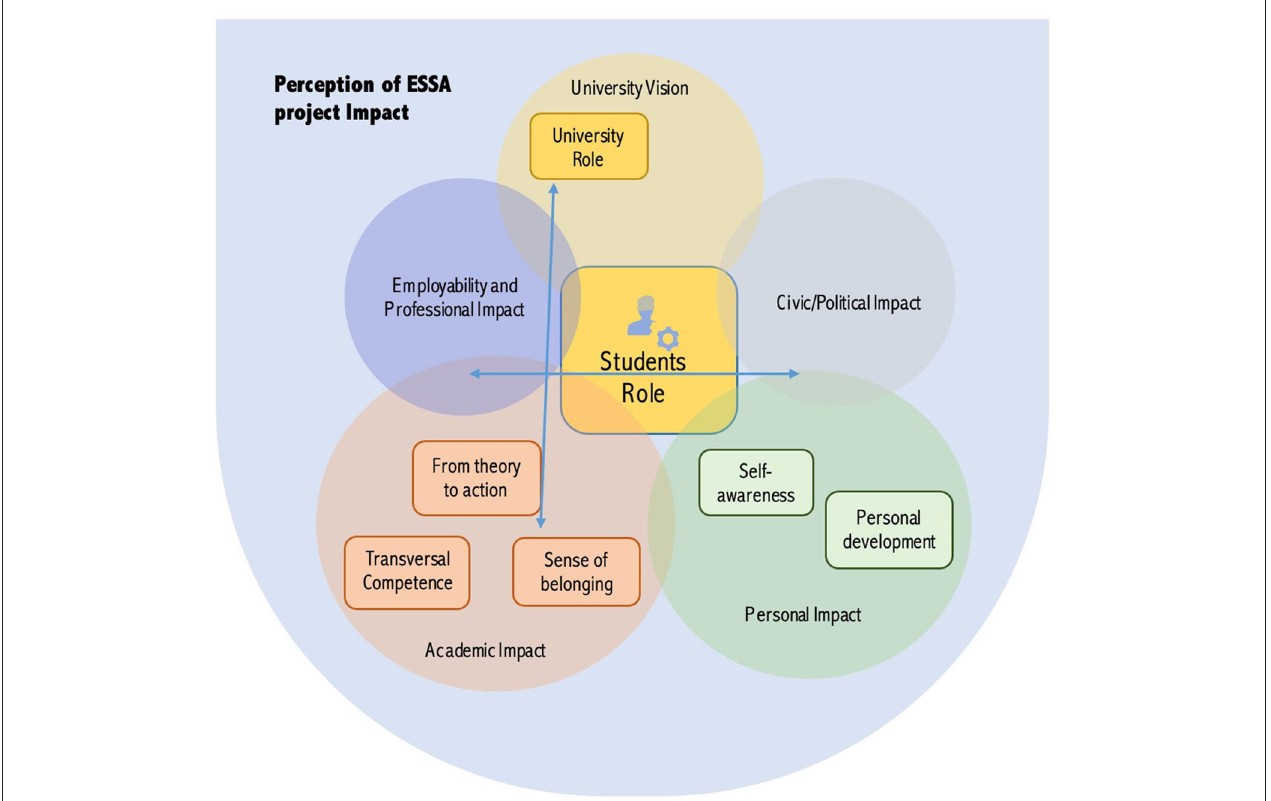
FIGURE 1 | Thematic